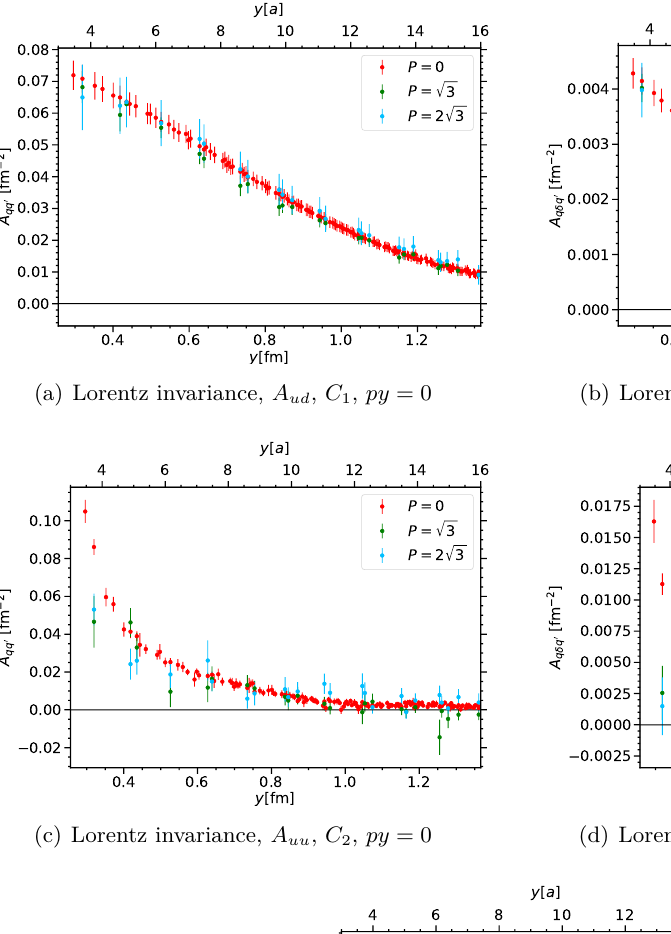
contributions to A 1